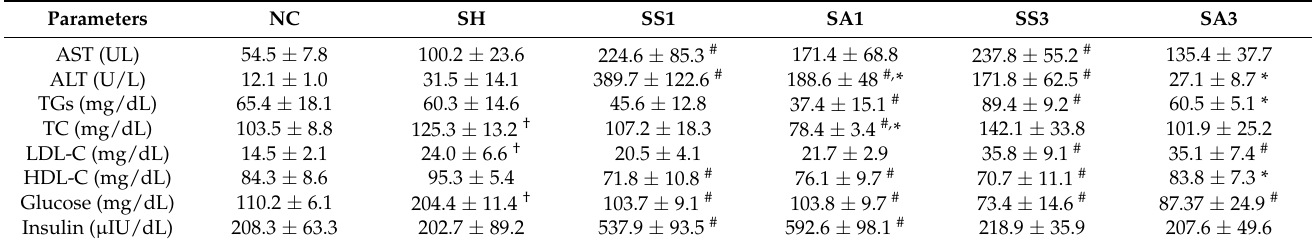
Figure 1. ( a ) Body weights, ( b ) epididymal fat weights, ( c ) dynamic changes in blood glucose levels, and ( d ) area under the curve (AUC) of mice fed the chow diet and high-fat diet (HFD) during the intraperitoneal glucose tolerance test (IPGTT). NC: normal control; n = 6 for each group. Data are presented as the mean ± SEM. Differences between groups were analyzed by an unpaired t-test. * p < 0.05. Table 2. Plasma concentrations of biochemical parameters among the experimental